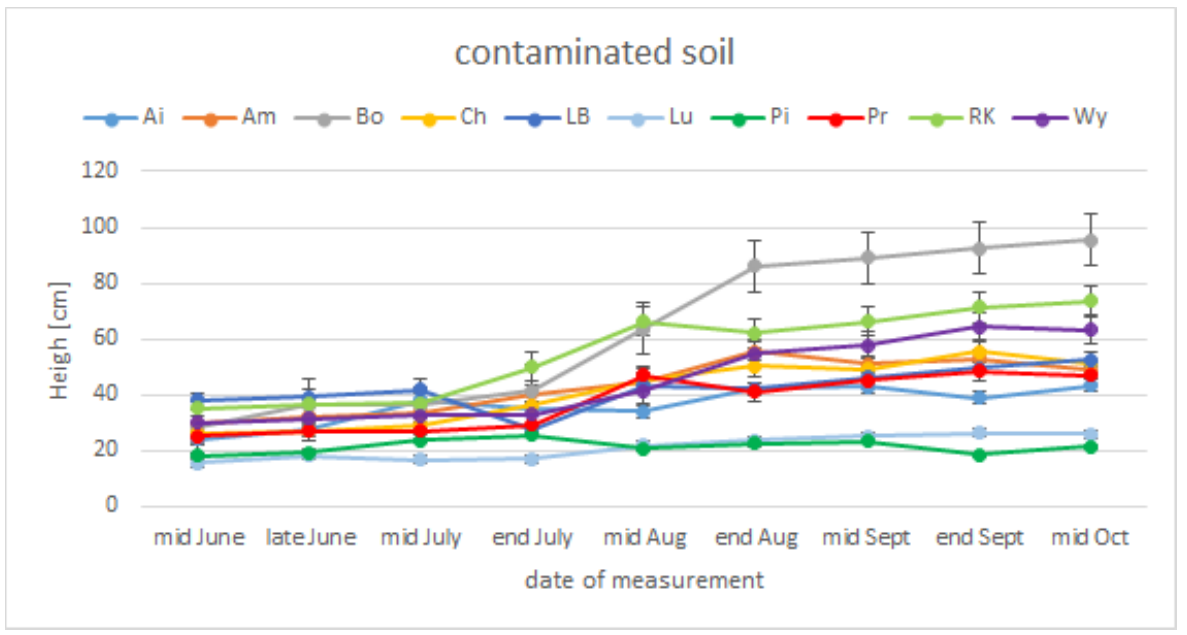
Figure 2. Dynamics of canna growth on contaminated soil. Description of cultivars is given in Materials and Methods Section 2.1. The means ± SE is expressed by each value.